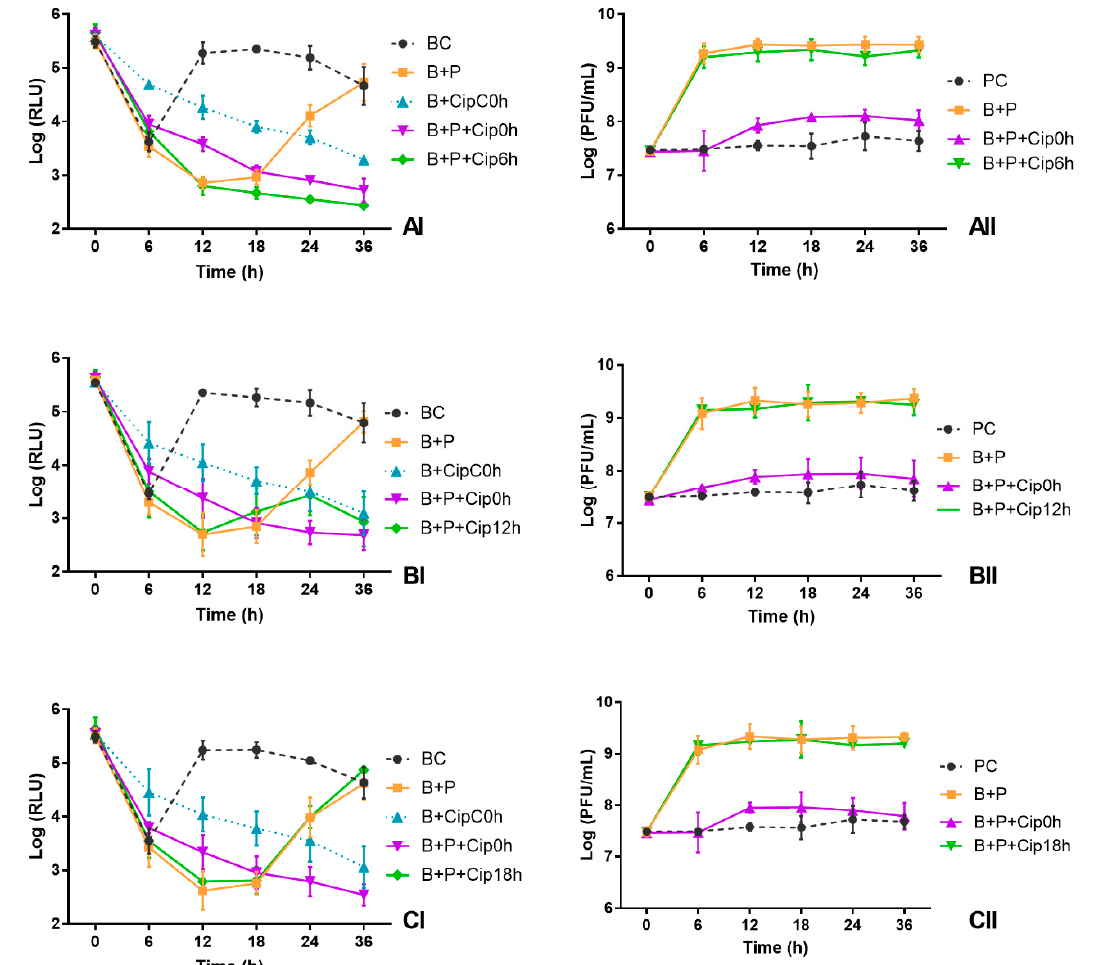
Figure 5. Effect of time of ciprofloxacin addition at 1 × MIC on the inactivation of bioluminescent E. coli (I) and the phage concentration (II) in TSB during 36 h: ( A ) antibiotic added after 6 h of phage addition; ( B ) antibiotic added after 12 h of phage addition; and ( C ) antibiotic added after 18 h of phage addition. BC, Bacterial control; PC, Phage control; B + P, Bacteria plus phage; B + CipC0h, Bacteria plus antibiotic added at the same time of the phage; B + P + Cip0h, Bacteria plus phage plus antibiotic added at the same time of the phage; B + P + Cip6h, Bacteria plus phage plus antibiotic added at 6 h of phage addition; B + P + Cip12h, Bacteria plus phage plus antibiotic added at 12 h of phage addition; B + P + Cip18h, Bacteria plus phage plus antibiotic added at 18 h of phage addition. Values represent the mean of three independent experiments.